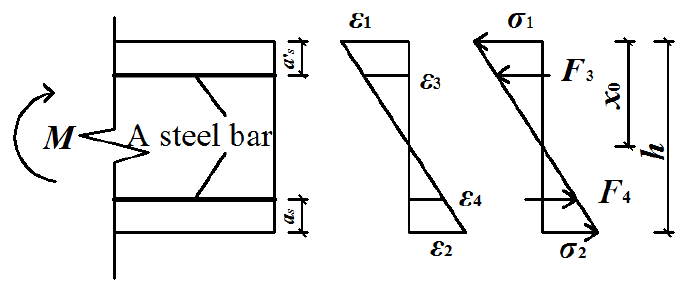
Figure 4. The section strain and stress corresponding to bending moment.